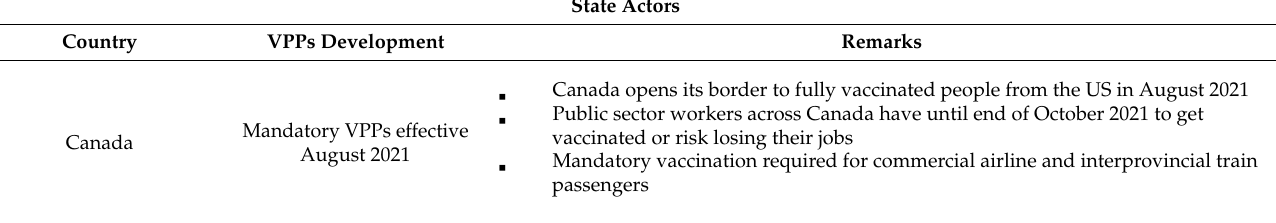
Table 1. Examples of state and non-state actors implementing/planning vaccine passport policies (VPPs).